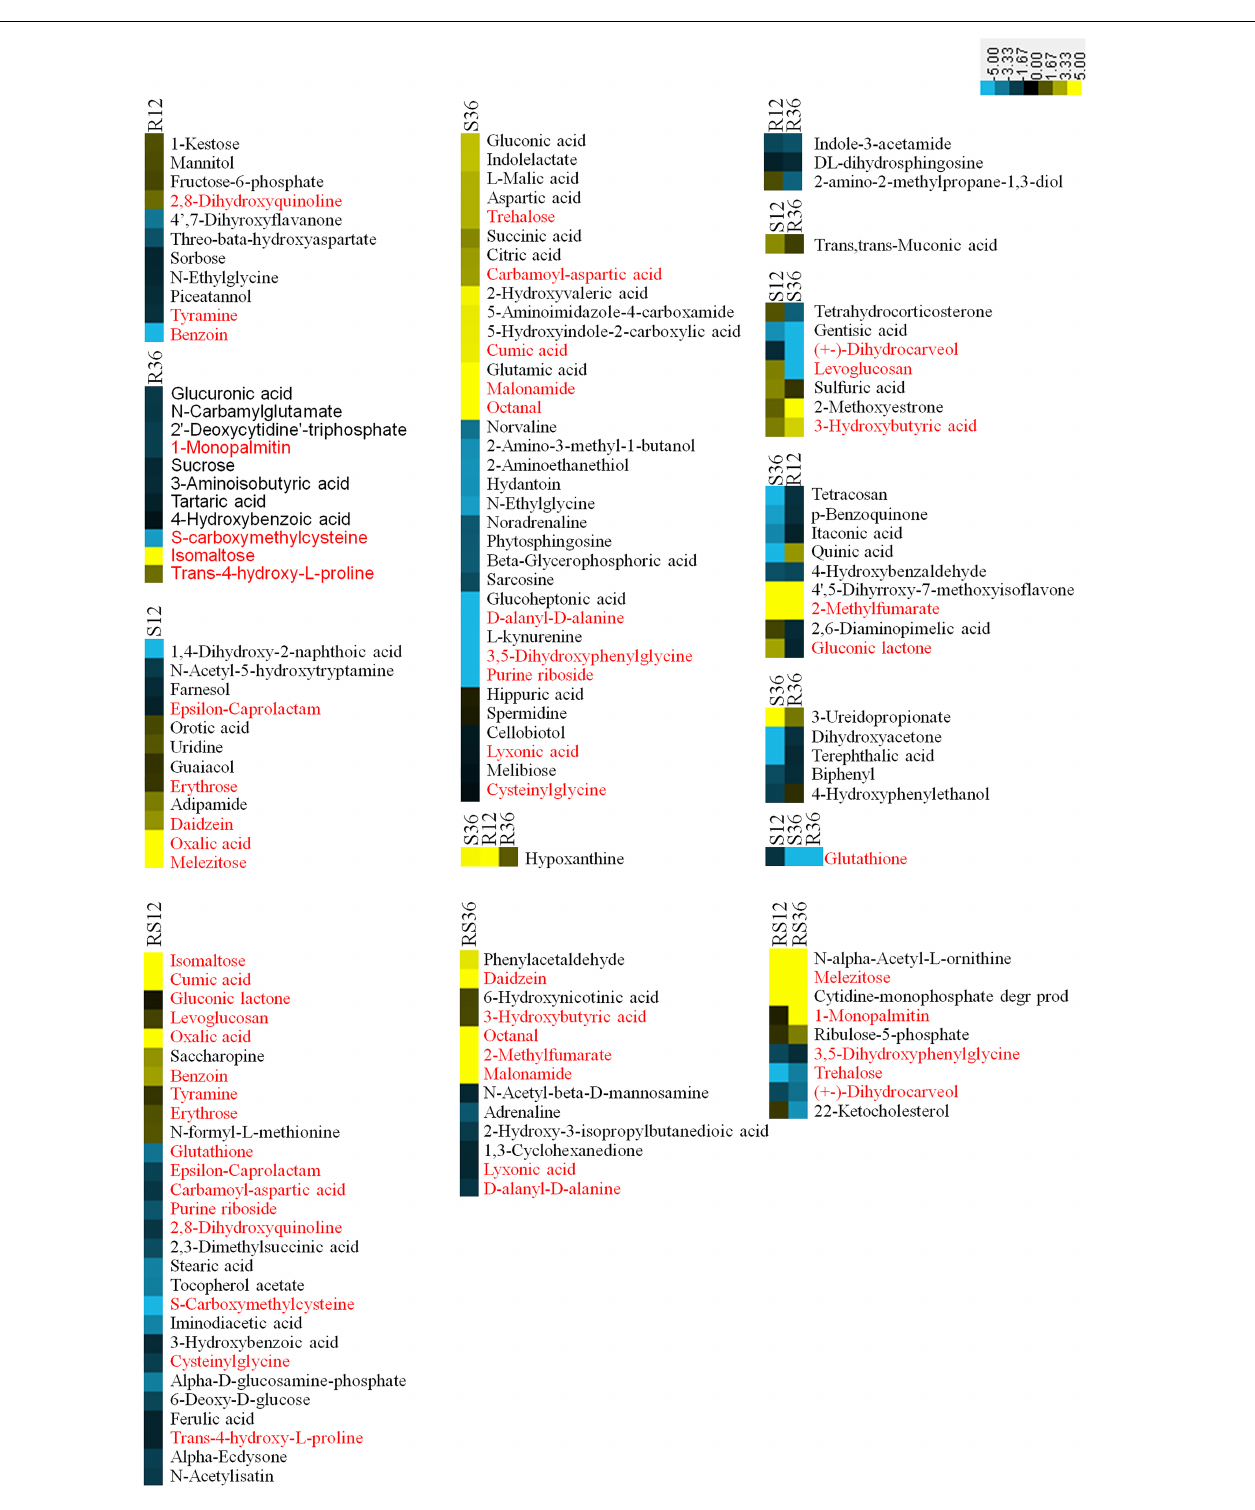
FIGURE 2 | Heatmaps of DAMs from each subset of a Venn diagram. Metabolites in red font were differentially accumulated between the R line and the S line as well as being differentially accumulated after P. sojae infection. The log 2 Fold change was colored using Cluster 3.0 (yellow for upregulation and blue for downregulation), and each horizontal row represents a DAM with its name. R12: R-12h-IN vs. R-12h-CK; R36: R-36h-IN vs. R-36h-CK; S12: S-12h-IN vs. S-12h-CK; S36: S-36h-IN vs. S-36h-CK; RS12: R-12h-CK vs. S-12h-CK; and RS36: R-36h-CK vs. S-36h-CK. IN, inoculated; CK, control check. A color bar is in the upper right corner.